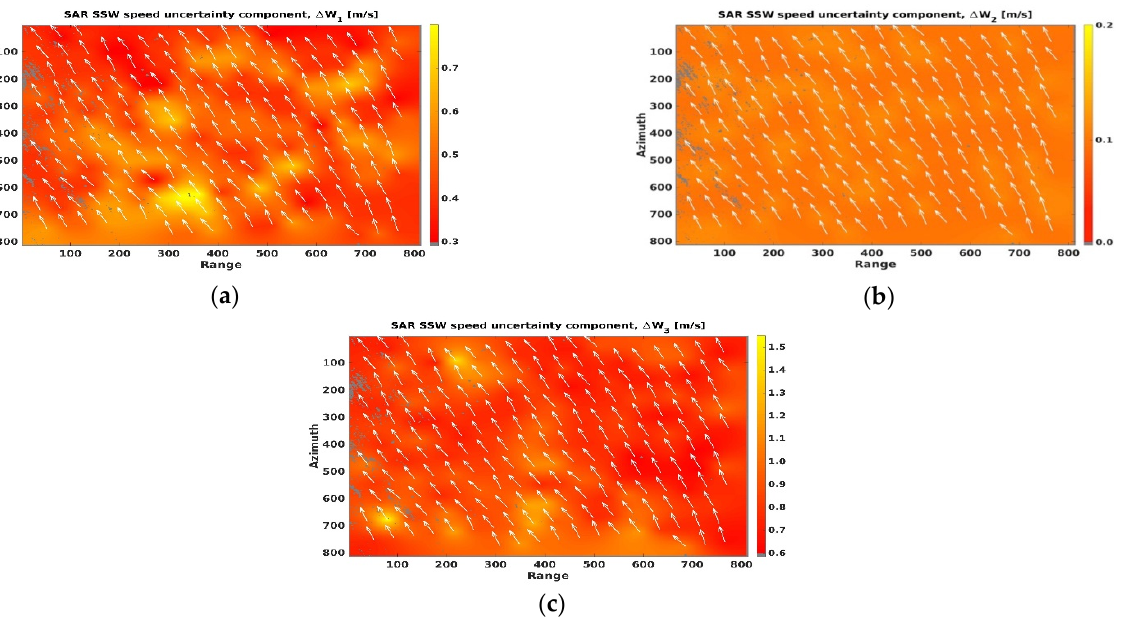
Figure 7. Contribution to the total CMOD5.N-derived SAR SSW speed uncertainty ∆ W max (m/s) (shown in Figure 6h), due to the true state ( σ 0 , θ , ϕ ) and a single uncertainty term among the ones regarding the NRCS ( ∆ σ 0 ) ( a ), the incidence angle ( ∆ θ ) ( b ), and the MS LG-Mod SSW (relative) direction ( ∆ ϕ ) ( c ). All maps are obtained at 5 km by 5 km from a Sentinel-1 IW image, ascending, VV-polarised, acquired on 16th May 2018 at 17:33:28 UTC. Estimated SSW vectors are superimposed.